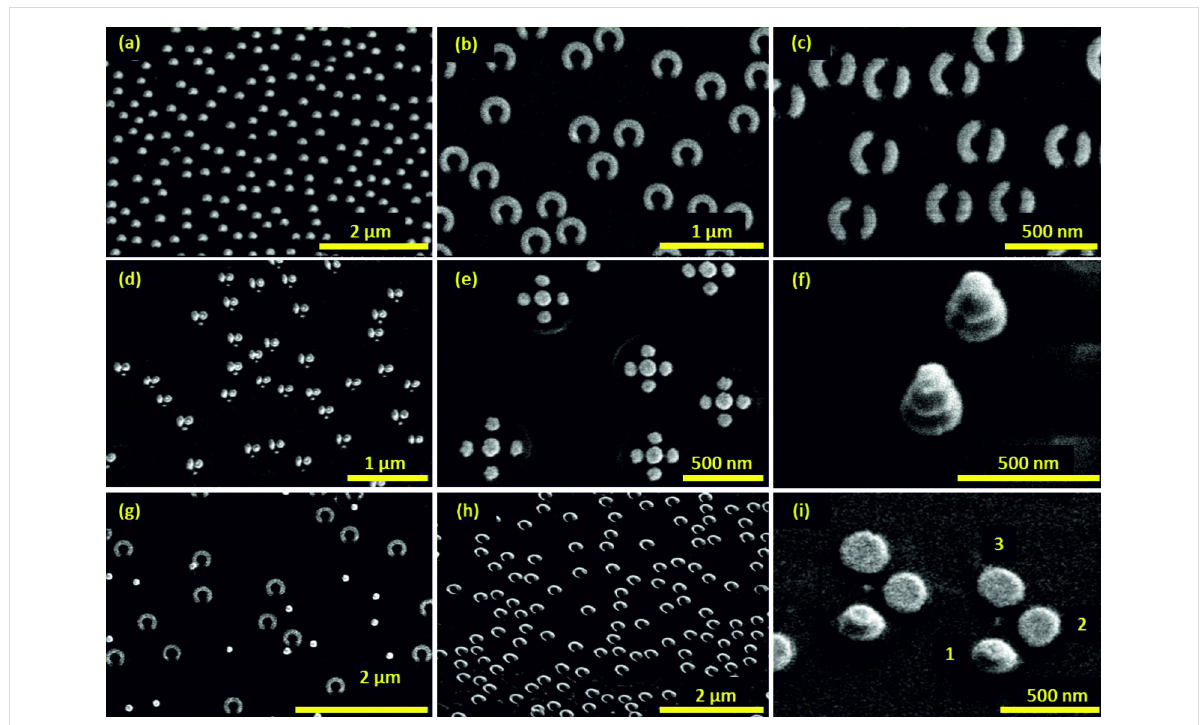
Figure 4: A variety of different nanostructures fabricated by hole-mask colloidal lithography: (a) ellipses, (b) split-rings, (c) asymmetric double split- rings, (d) dimers, (e) pentamers, (f) three-layer stacked gold disks, (g) disks and split-rings by multilayer fabrication, (h) 3D chiral gold spirals, (i) 3D chiral tetramers. All structures are fabricated with hole-masks, which are prepared by 119 nm diameter PS spheres and 230 nm PMMA, except samples (f) and (i), for which 220 nm diameter PS spheres and 480 nm PMMA are used. The small disks near the dimer structures in panel (d) stem from the clogging effect of the mask during the evaporation of the third structure